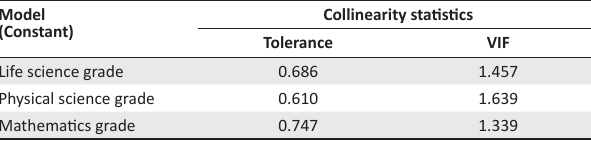
TABLE 3: Collinearity test (coefficients a